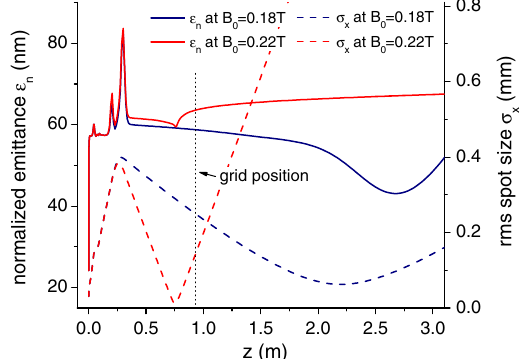
FIG. 8. Comparison of the emittance (solid lines) and spot size (dashed lines) along the beam line for the ‘‘optimal emittance mode’’ ( B 0 ¼ 0 : 18 T ) and the ‘‘emittance measurement mode’’ ( B 0 ¼ 0 : 22 T ). The solenoid strength is tuned to deliver the